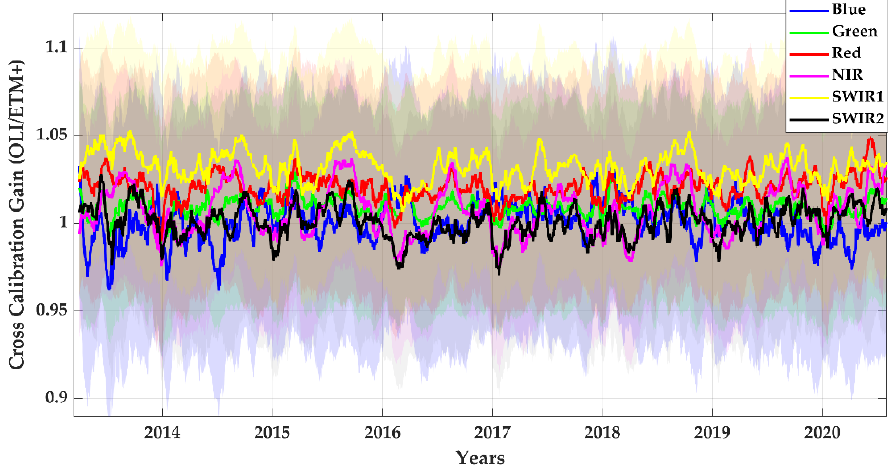
Figure 14. The trend-to-trend cross-calibration gain of Landsat 8 OLI and Landsat 7 ETM+. The shaded region is the uncertainty for individual band.